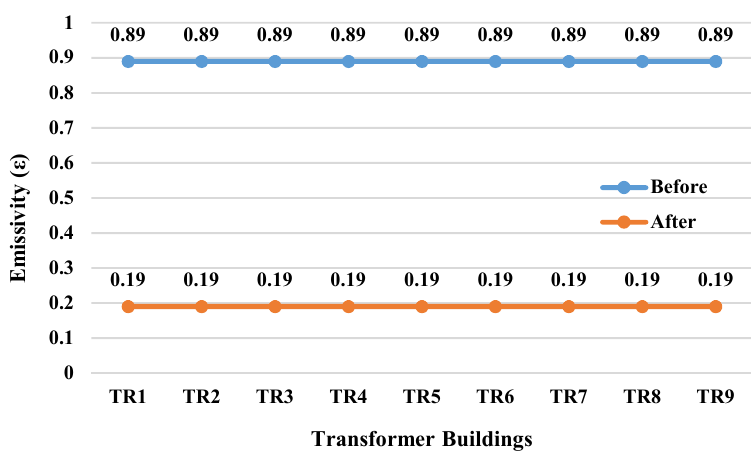
Figure 4. Emissivity values before and after absorbing the (low-emissivity) coating.